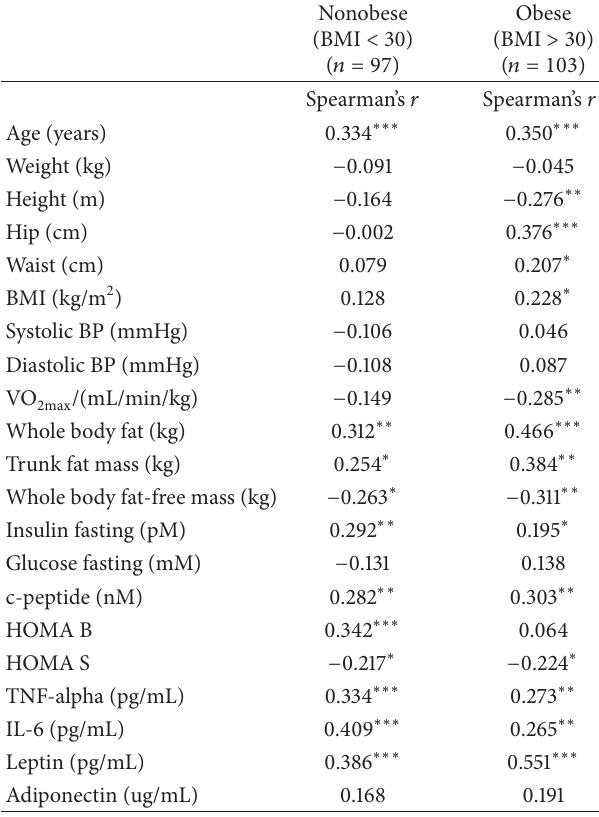
Table 3: Associations between plasma follistatin-like 3 and bio- chemical and demographic markers in obese and nonobese